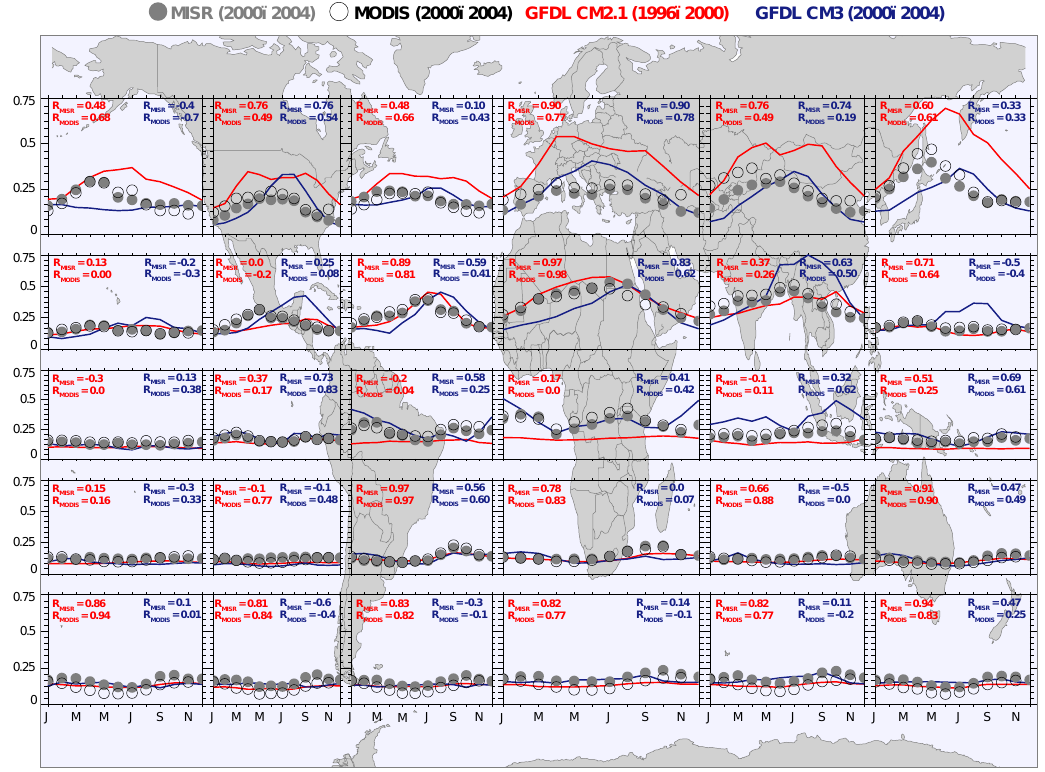
Figure 3. Regional observed (MISR: grey circles, MODIS: open circles) and model-derived (CM2.1: red lines, CM3: blue lines) monthly aerosol optical depth at 550nm. Values are surface-weighted averages within each panel. Correlations between observed and simulated AODs are